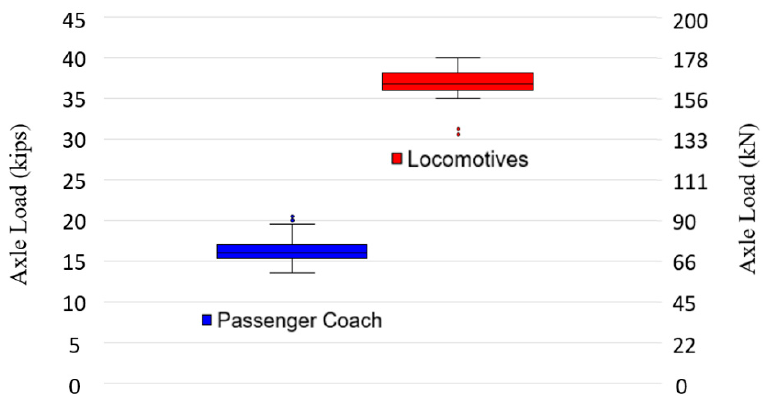
Figure 9. The distribution of the wheel loads measured at site.